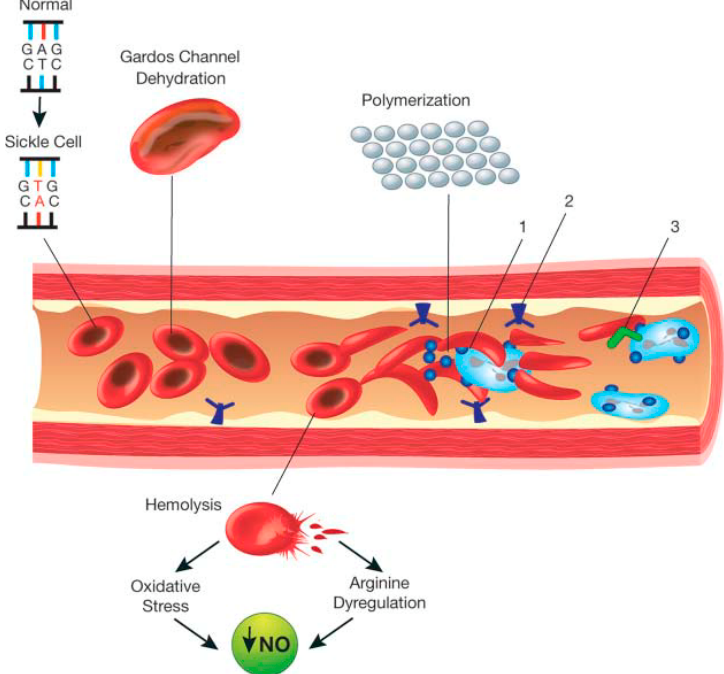
Figure 1. Schematic representation of the pathophysiology (in part) of sickle cell anemia. A